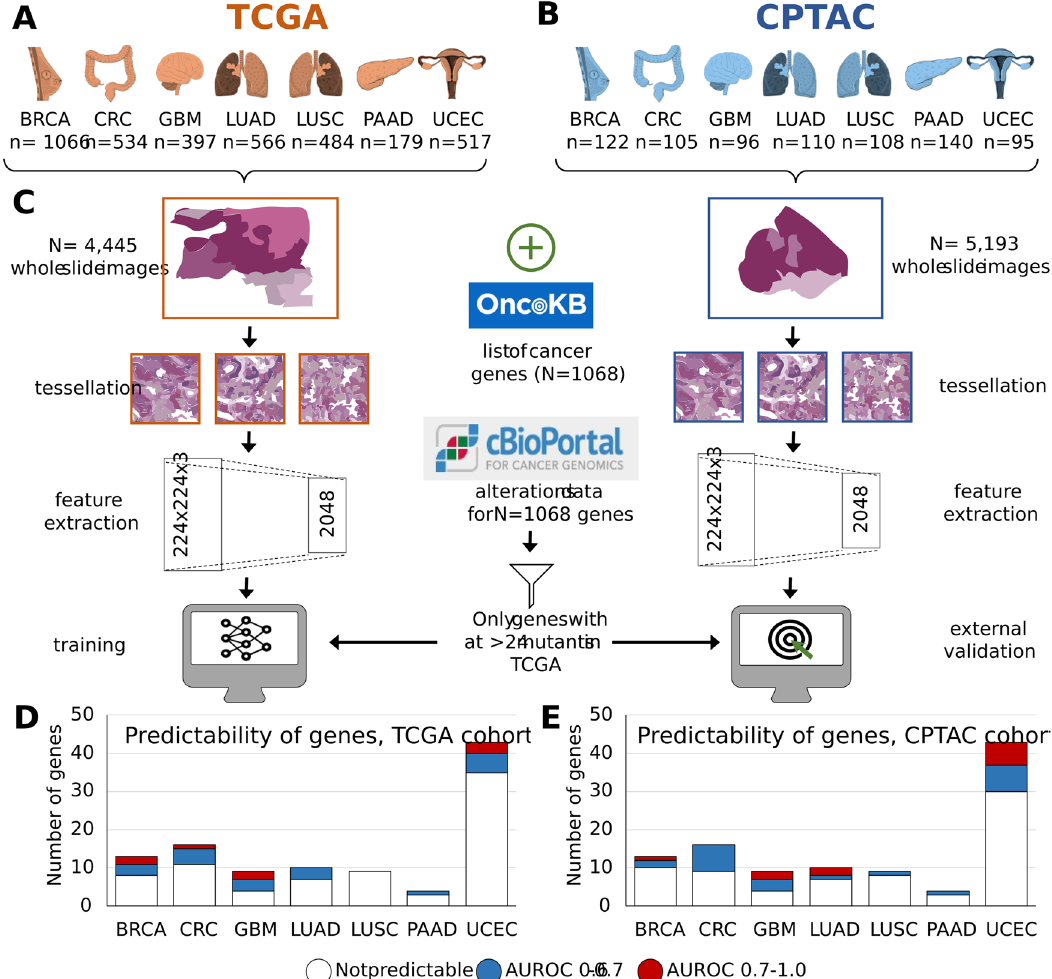
Fig. 1 Study Design with selection process of the genes. A , B Patient numbers for each tumor type in The Cancer Genome Atlas (TCGA) and the Clinical Proteomic Tumor Analysis Consortium (CPTAC) dataset. C Flowchart showing the preprocessing steps for the training and validation cohort. Furthermore, an outline of the gene selection process. D Overview Area under the receiving operating curve (AUROC) results for internal cross-validation in TCGA. E Overview AUROC results for external validation on CPTAC. The plots are based on the original AUROC values with 5 decimal digits, while numbers in the manuscript text have been rounded to two decimal digits. (Icons were used from Servier Medical Art provided by Servier, licensed under a Creative Commons Attribution 3.0 unported